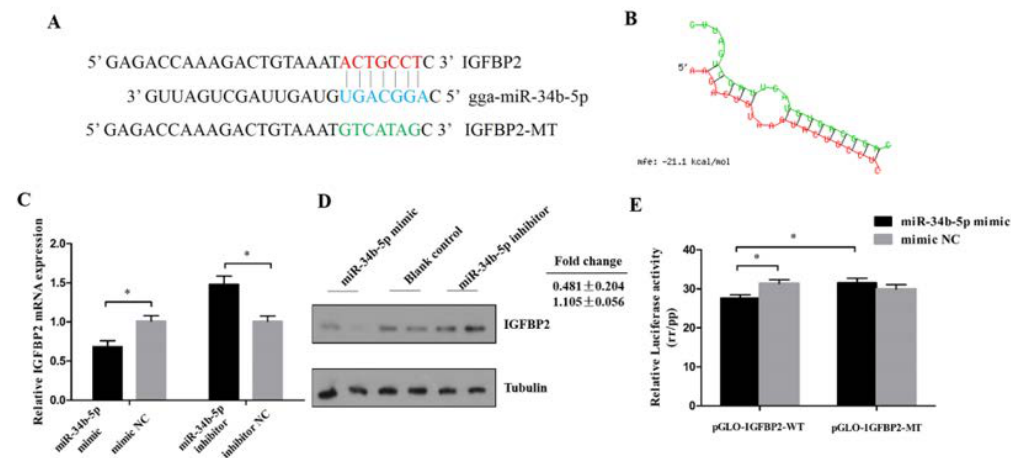
Figure 3. IGFBP2 is a direct target of miR-34b-5p. ( A ) The miR-34b-5p binding site in the IGFBP2 mRNA 3 (cid:48) UTR. The seed sequence and mutant sequence in miR-34b-5p were highlighted in blue and green, respectively. ( B ) The potential miR-34b-5p targeting site in IGFBP2 mRNA 3 (cid:48) UTR was analyzed by RNAhybrid software. ( C , D ) The mRNA and protein level of IGFBP2 in CPM cells after being transfected with miR-34b-5p mimic or inhibitor. ( E ) The dual-luciferase reporter assay was performed by co-transfecting a wild-type or mutant IGFBP2 3 (cid:48) UTR with miR-34b-5p mimic or mimic NC in DF-1 cells. Results are shown as mean ± S.E.M. and the data are representative of at least three independent assays. Independent sample t-test was used to analyze the statistical differences between groups. (* P <